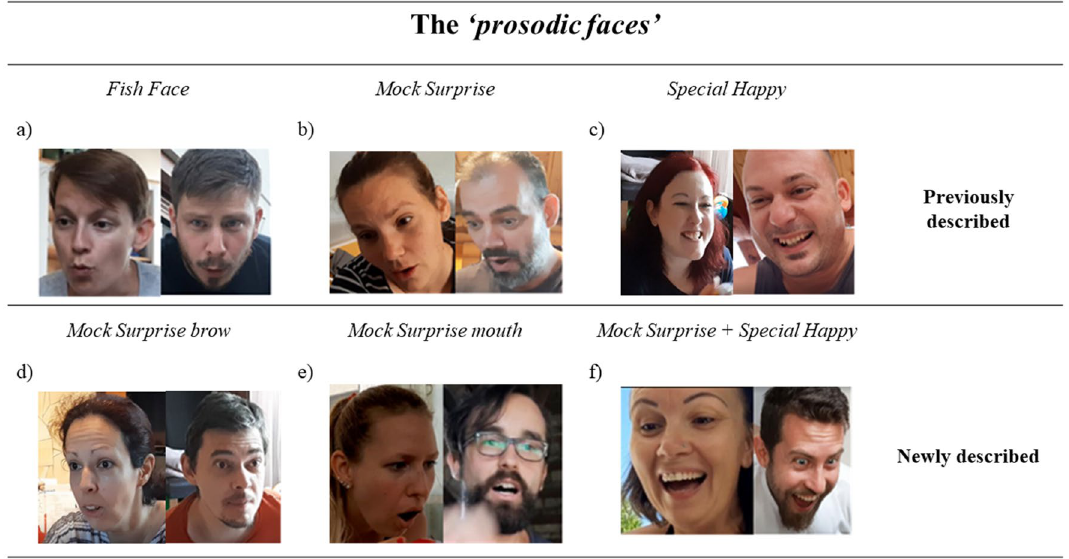
Figure 1. The ‘prosodic faces’ : three facial displays from Stern 17 and Chong et al. 15 and three additional faces that we have identified in the present